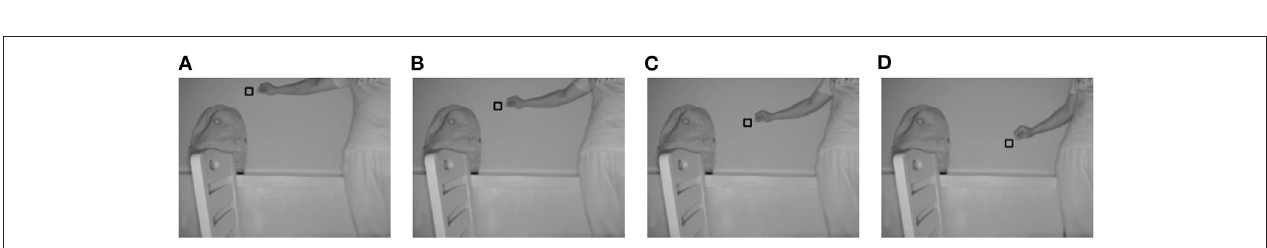
FIGURE 5 | Tracking results from the method of weighting the data source into which depth information is introduced. (A) The 10th frame; (B) the 30th frame; (C) the 50th frame; (D) the 80th frame.